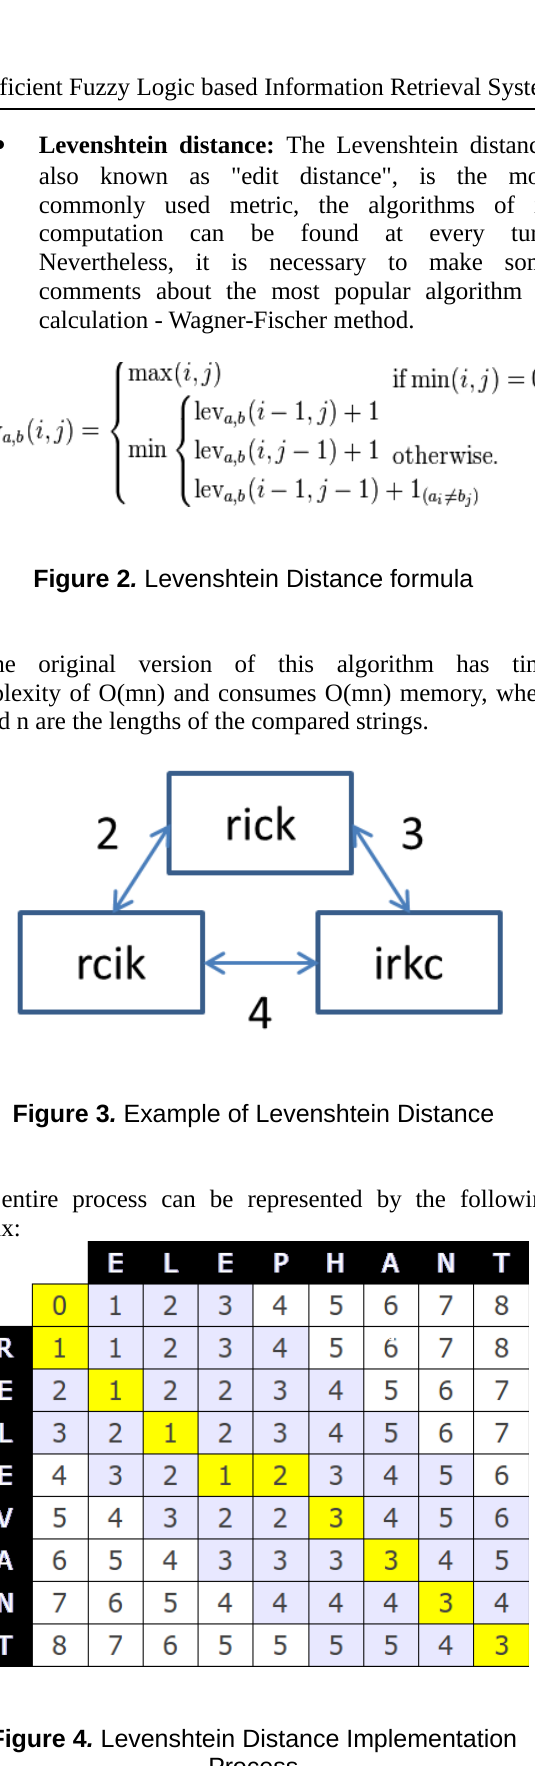
Figure 4 . Levenshtein Distance Implementation